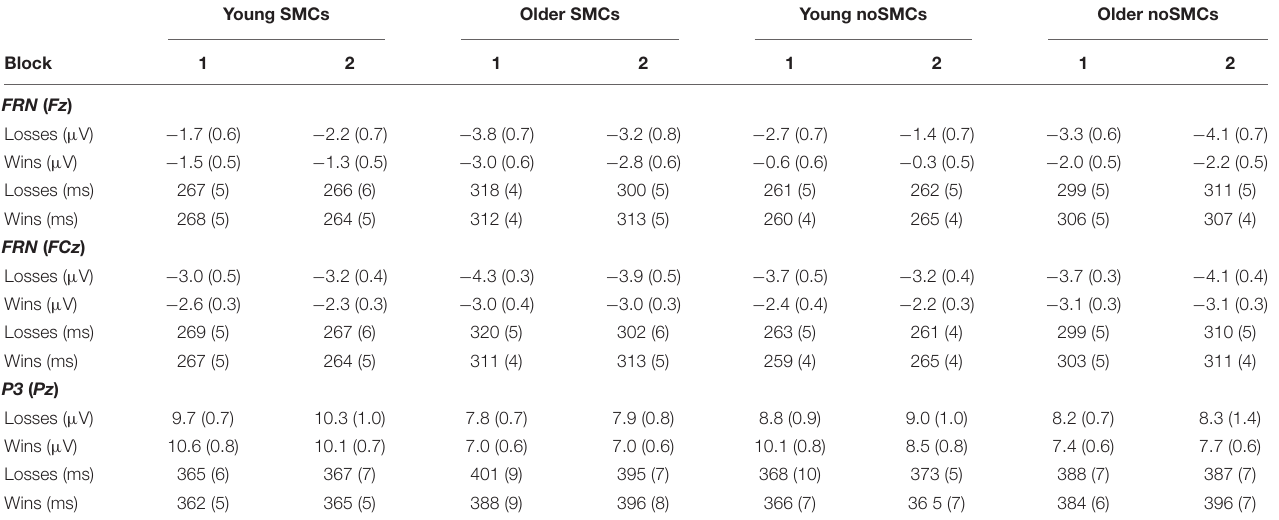
TABLE 2 | Event-related potential (ERP)